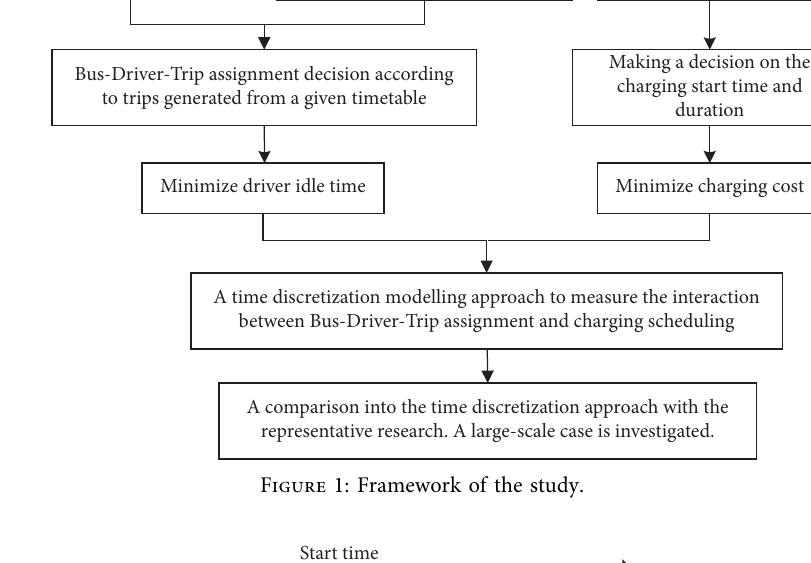
Figure 1: Framework of the study.